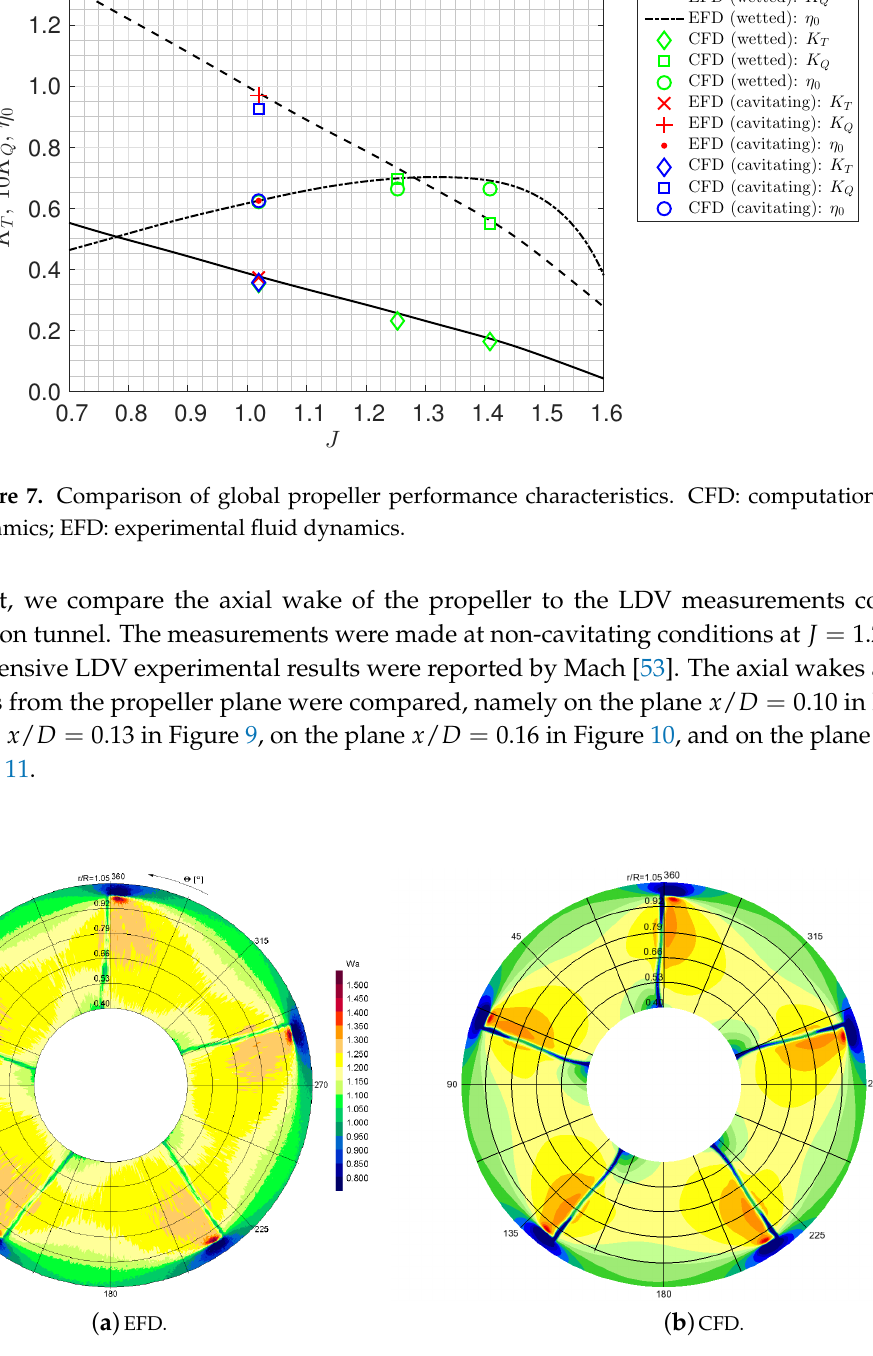
Figure 8. Comparison of axial wake distributions at x / D = 0.10 behind the